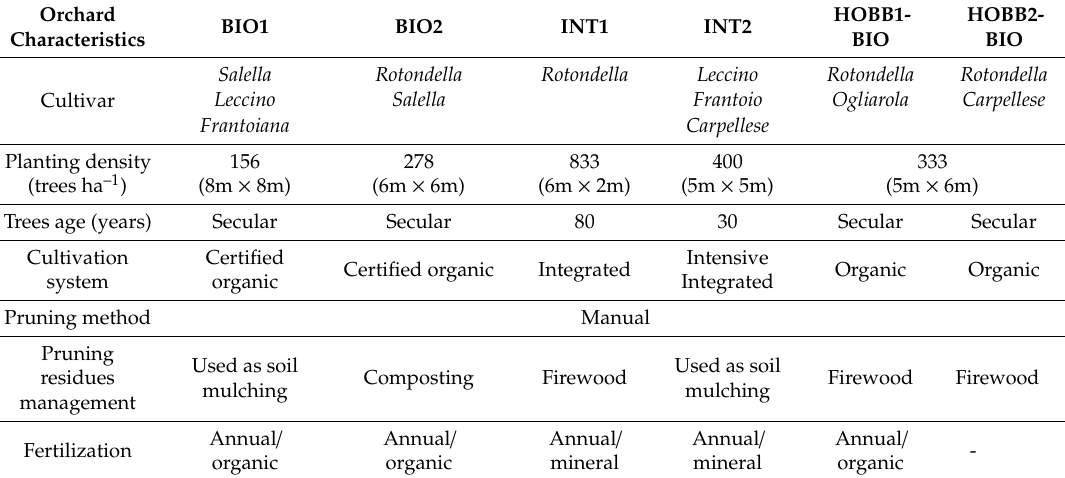
Table 1. Technical and agronomic characteristics of the analyzed